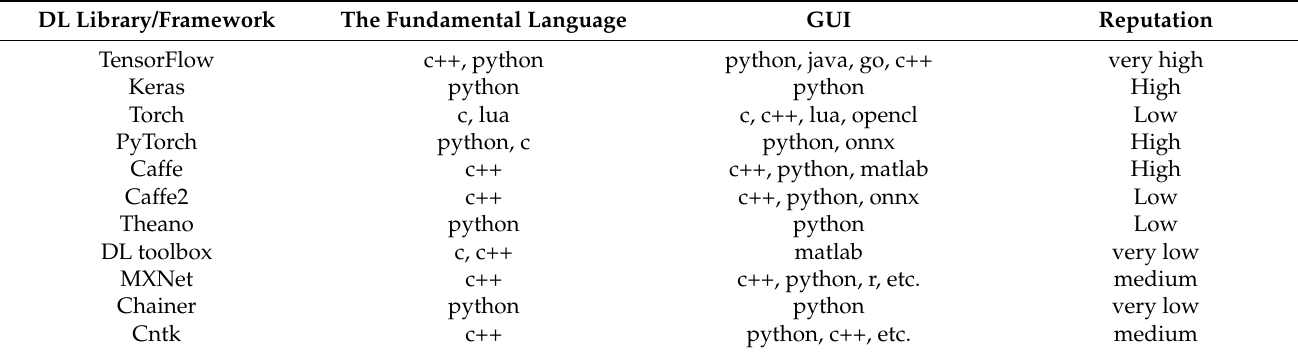
Table 6. A Summary of the Most Popular DL